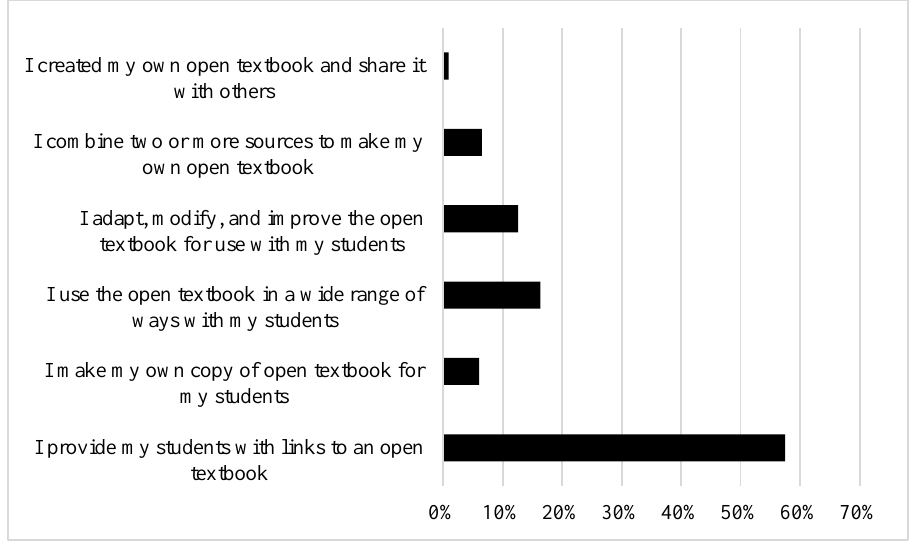
Figure 5 . Faculty use of open